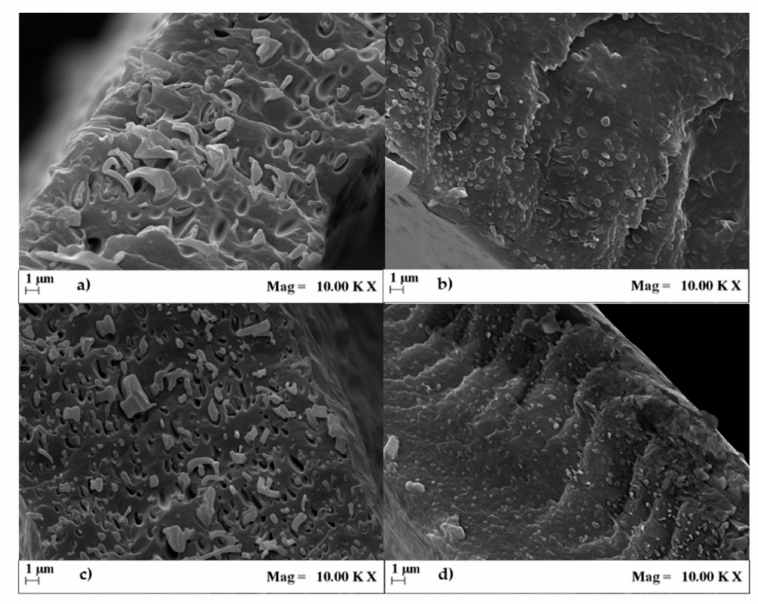
Figure 4. SEM picture of the fracture surfaces of ( a ) PBAT / PLA1, ( b ) PBAT / PLA2, ( c ) PBAT / PLA1 + J, and ( d ) PBAT / PLA2 +